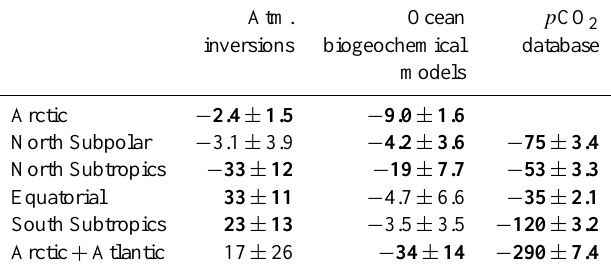
Table 8. Linear trends of the spatially integrated sea–air CO 2 flux for each region and whole Arctic + Atlantic, 1995 to 2009 [TgCyr − 1 decade − 1 ], for the atmospheric inversions, the ocean biogeochemical models and the p CO 2 database. Trends are a lin- ear fit to the low-frequency median flux IAV (i.e Fig. 6), with 2 σ confidence. Trends distinguishable from zero are indicated in bold. Atm. Ocean p CO 2 inversions biogeochemical database models Arctic − 2.4 ± 1.5 − 9.0 ± 1.6 North